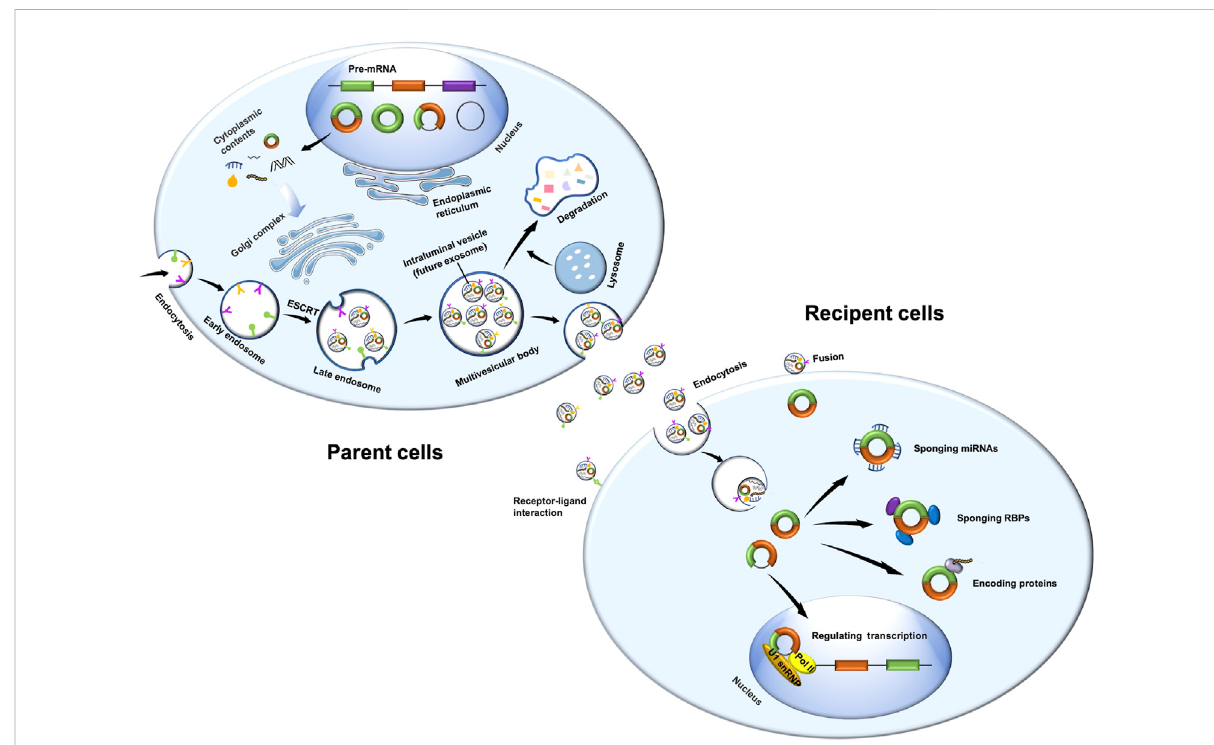
FIGURE 1 Biogenesis of exosomal circRNAs and its function in recipient cells. Exosomes are derived from endosomal system. Plasma membrane invagination results in the formation of early endosomes, whose membranes are then invaginated and sprouted to form intraluminal vesicles. At the same time, the early endosomes mature into multivesicular bodies. These intraluminal vesicles are essentially exosomes. Multivesicular bodies fuse with cell membrane, and exosomes are subsequently released to extracellular surroundings. CircRNAs are derived from pre-mRNA, which covalently connects both ends of a single RNA molecule during backsplicing to form a closed loop. CircRNAs have four main types, namely, intron- derived circRNAs, exonic circRNAs, exon-intron circRNAs, and intergenic circRNAs. MiRNAs and RBPs may regulate the sorting of circRNAs